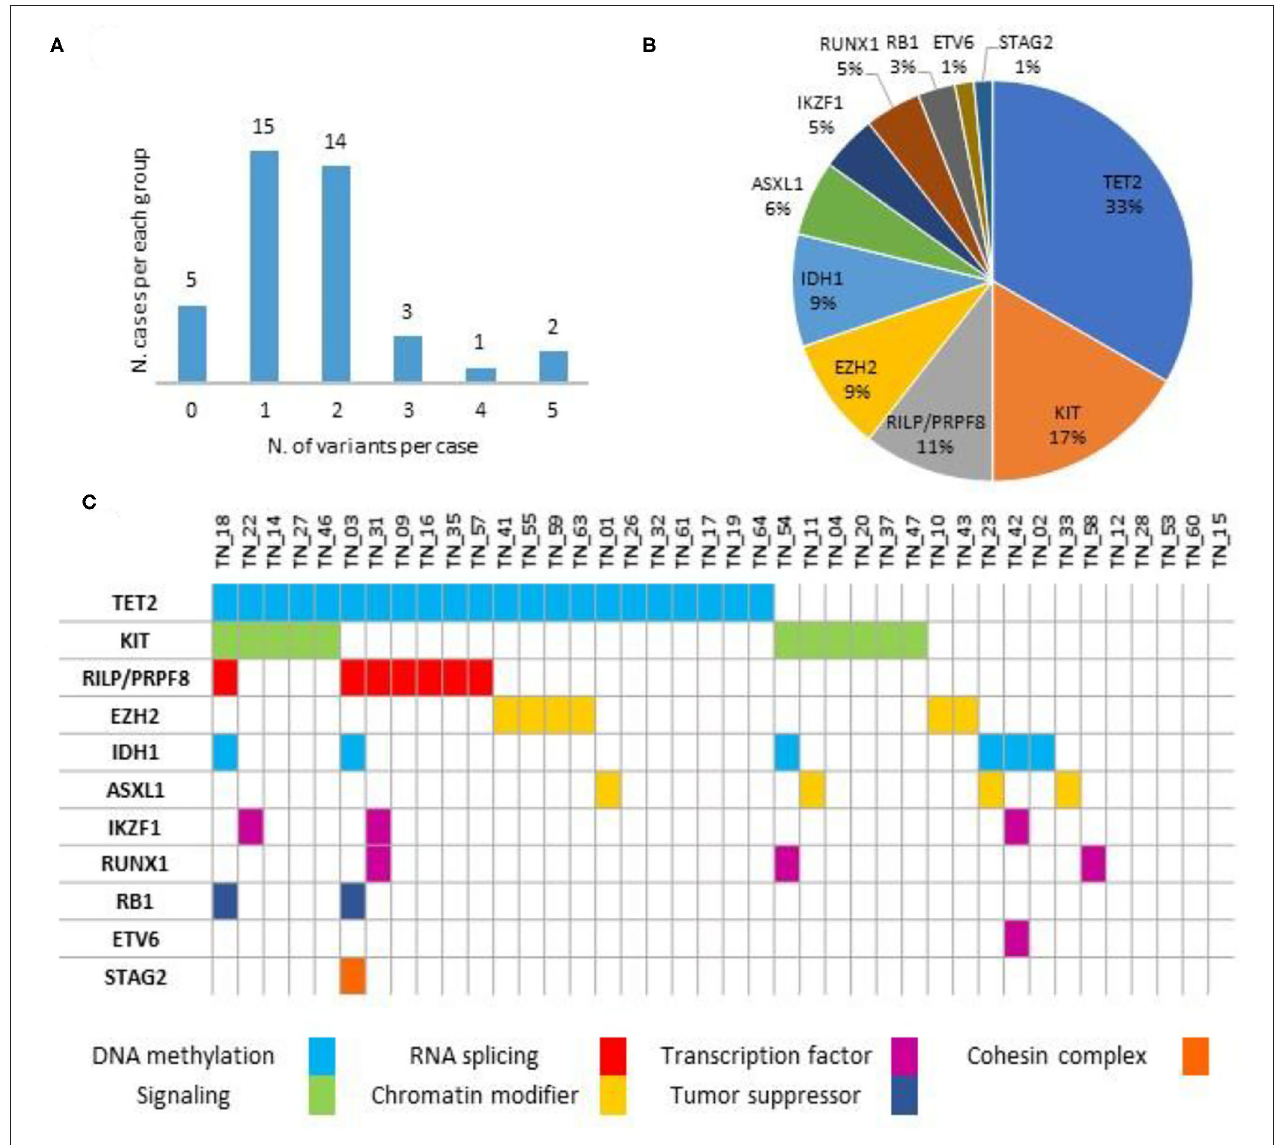
FIGURE 1 | Variants distribution (A) , relative frequencies of pathogenic variants (B) and mutational spectrum (C) along the series ( n =